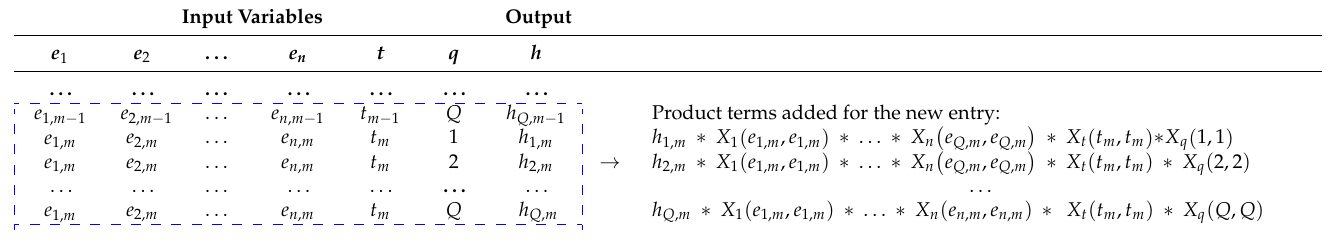
Table 3. Creation of new product term (shown to the right) in the storage function F ste for the newcomer entry e m = ( e 1, m , . . . , e n , m ) . Previous entry is e m − 1 = ( e 1, m − 1 , . . . , e n , m − 1 ) and the number of used verifiers is Q . Service variables q and t respond to the time stamp and the counter of verifiers.